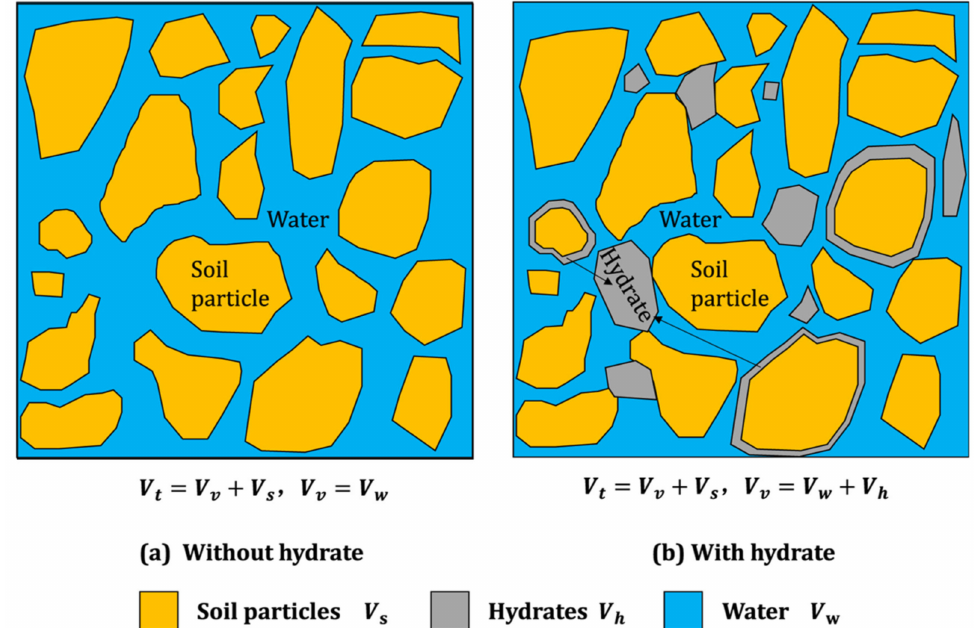
Figure 26. Schematic diagram of sediment ( a ) without hydrate and ( b ) with hydrate reprinted from [58] with permission from Elsevier.